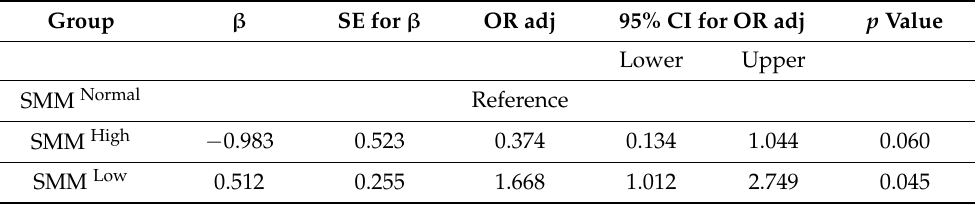
Table 2. Association of SMM with incompletely controlled asthma (ACQ ≥ 0.75) using multivariable logistic regression with adjustment for confounders.